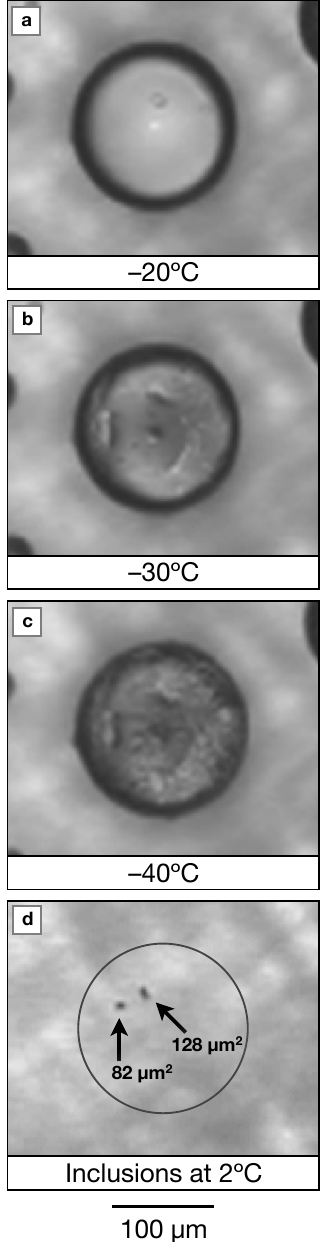
Fig. 2. Images from a heterogeneous nucleation experiment. Im- age (a) shows a liquid water droplet (cell temperature of − 20.0 ◦ C) containing Cladosporium spore inclusions (not visible) where no freezing has yet occurred. Images ( b and c ) (cell temperatures of − 30.0 ◦ C and − 40.0 ◦ C, respectively) show the droplet after freez- ing. Image (d) depicts the remaining inclusions (with a total area of 210µm 2 ) upon evaporating the droplets at 2.0 ◦ C and passing dry He gas through the cell. For reference, the droplet boundary is pro- vided as a black outline and the individual areas of the inclusions are